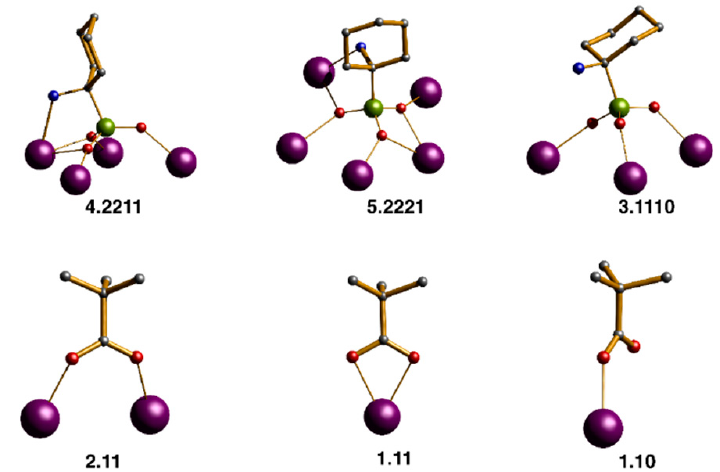
Figure 3. Scheme for binding modes by Harris notation of the phosphonates and acetates in the clusters 1 and 2. Scheme: Ln, purple; P, light green; O, red; C, grey; N, cyan; H omitted for clarity.